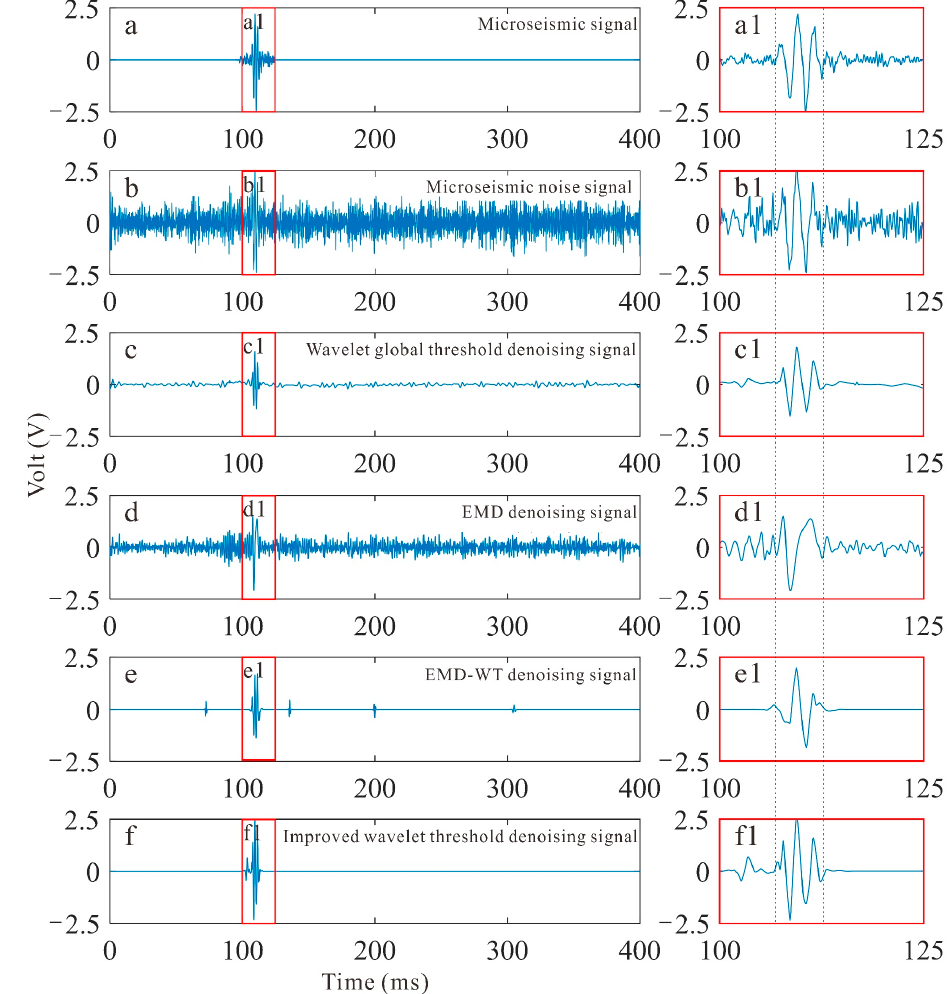
Figure 5. Comparison of the denoising results of different methods for noise-containing synthetic microseismic signal: ( a , a1 ) microseismic signal, ( b , b1 ) microseismic noise signal, ( c , c1 ) Wavelet global threshold denoising signal, ( d , d1 ) EMD denoising signal, ( e , e1 ) EMD-WT denoising signal, ( f , f1 ) improved wavelet threshold denoising signal.